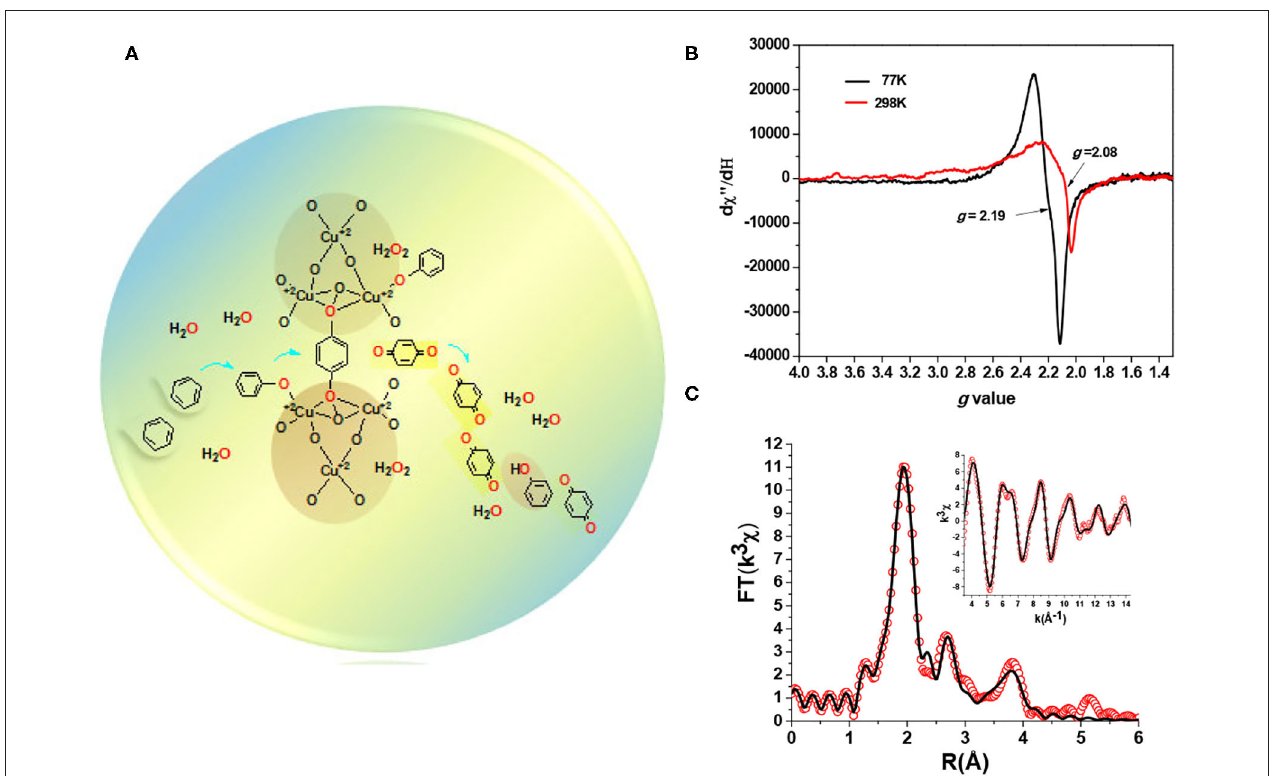
FIGURE 3 | (A) The proposed reaction sphere in recyclable copper nano-catalyst with the active site for selective oxidation of benzene to p -benzoquinone ( p -BQ) using H 2 O 2(aq) in CH 3 CN; (B) EPR spectra of copper oxide nanoparticles in KBr measured at 77 and 298K, respectively; (C) The Cu EXAFS (inset, red circle) and their Fourier transforms (red circle) as well as the corresponding best fits (black solid lines) of copper oxide nanoparticles using trinuclear copper cluster as the structural model ( Chan et al., 2013). Reproduced with permission from Wanna et al. (2019b). Copyright 2019 Elsevier B.V.